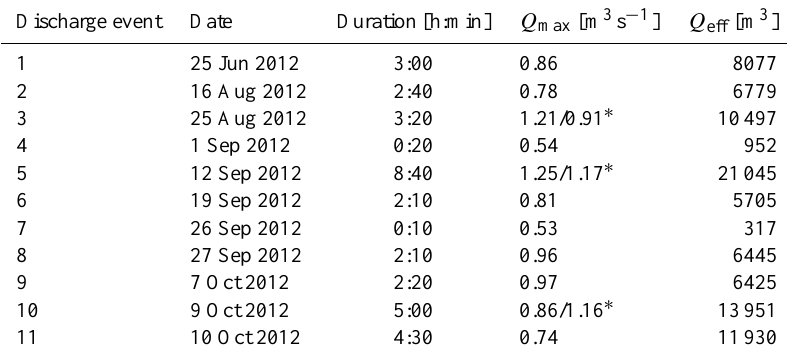
Table 2. Parameters of elevated discharge events above 0.5m 3 s − 1 in the Erlenbach that occurred between 22 June to 25 October 2012. This time period corresponds to the study period of the tracer experiment. Q max is the peak discharge of each event, Q eff is the effective volume of water that passed the gauge during periods with a discharge above 0.5m 3 s − 1 .